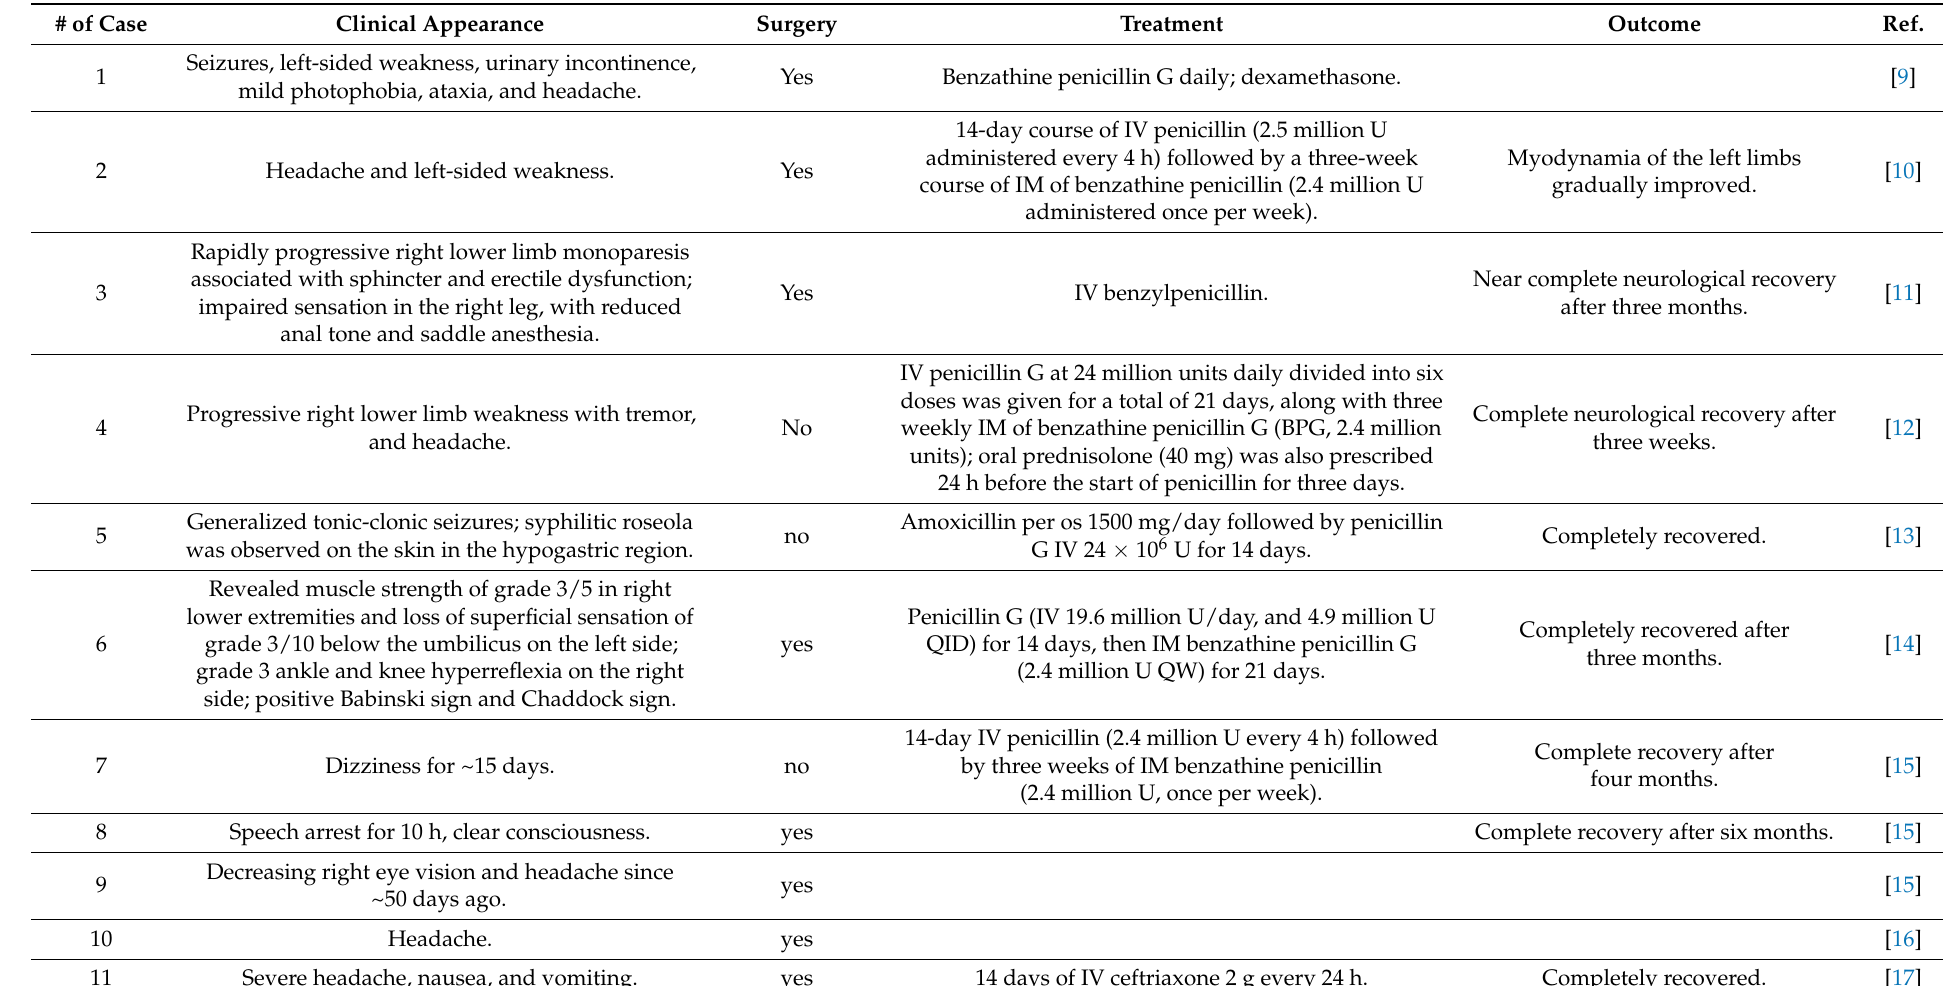
Table 2. Listed are all identified cases between the years 1990 and 2021. Ordered by years of the report (as in Table 1). Shown are how the patients clinically presented, whether an operation was carried out, which drug treatment was carried out, and the outcome. (Abbreviations: IM, intramuscular injection; IV, intravenous